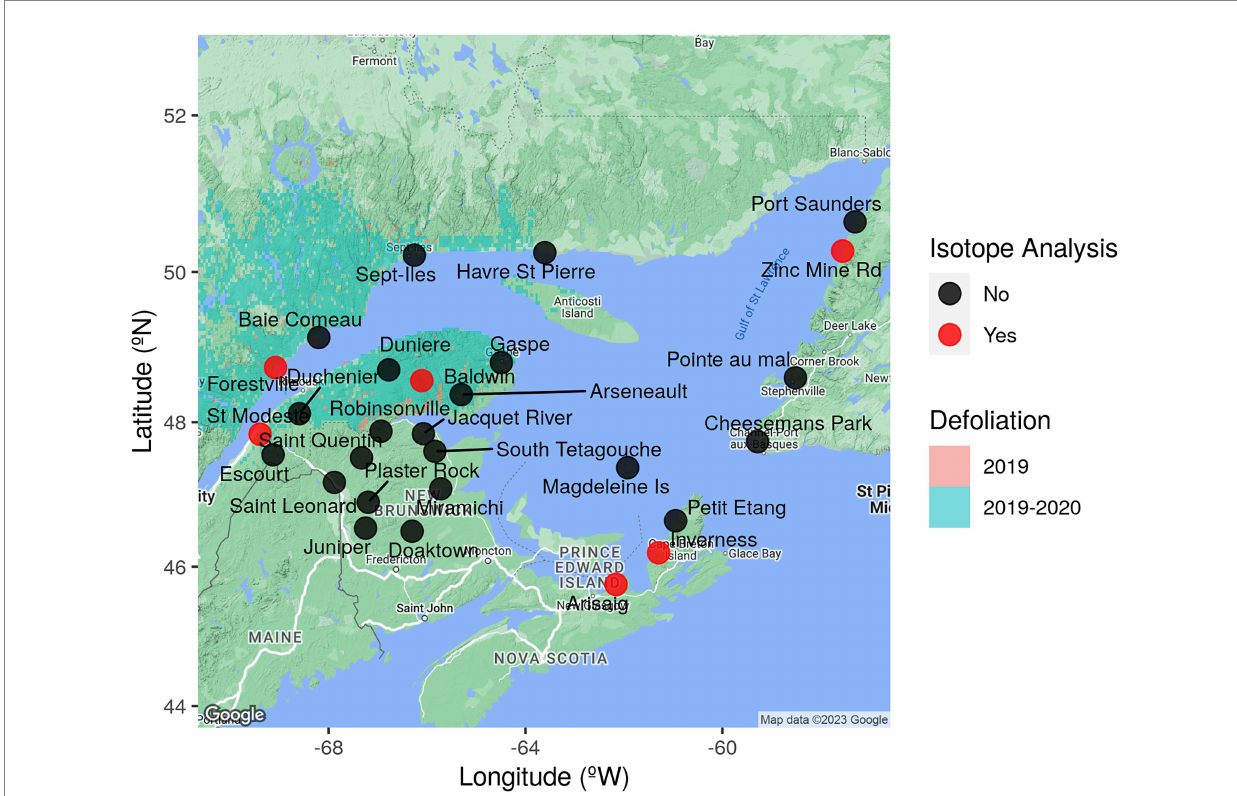
FIGURE 1 Trap location and eastern spruce budworm defoliation area. Map of eastern Canada with location of automatic traps in the network (black points), traps used in this study (red points) and the 2019 and 2020 spruce budworm area of defoliation, which is used as a proxy for population density and extent of the outbreak in a given